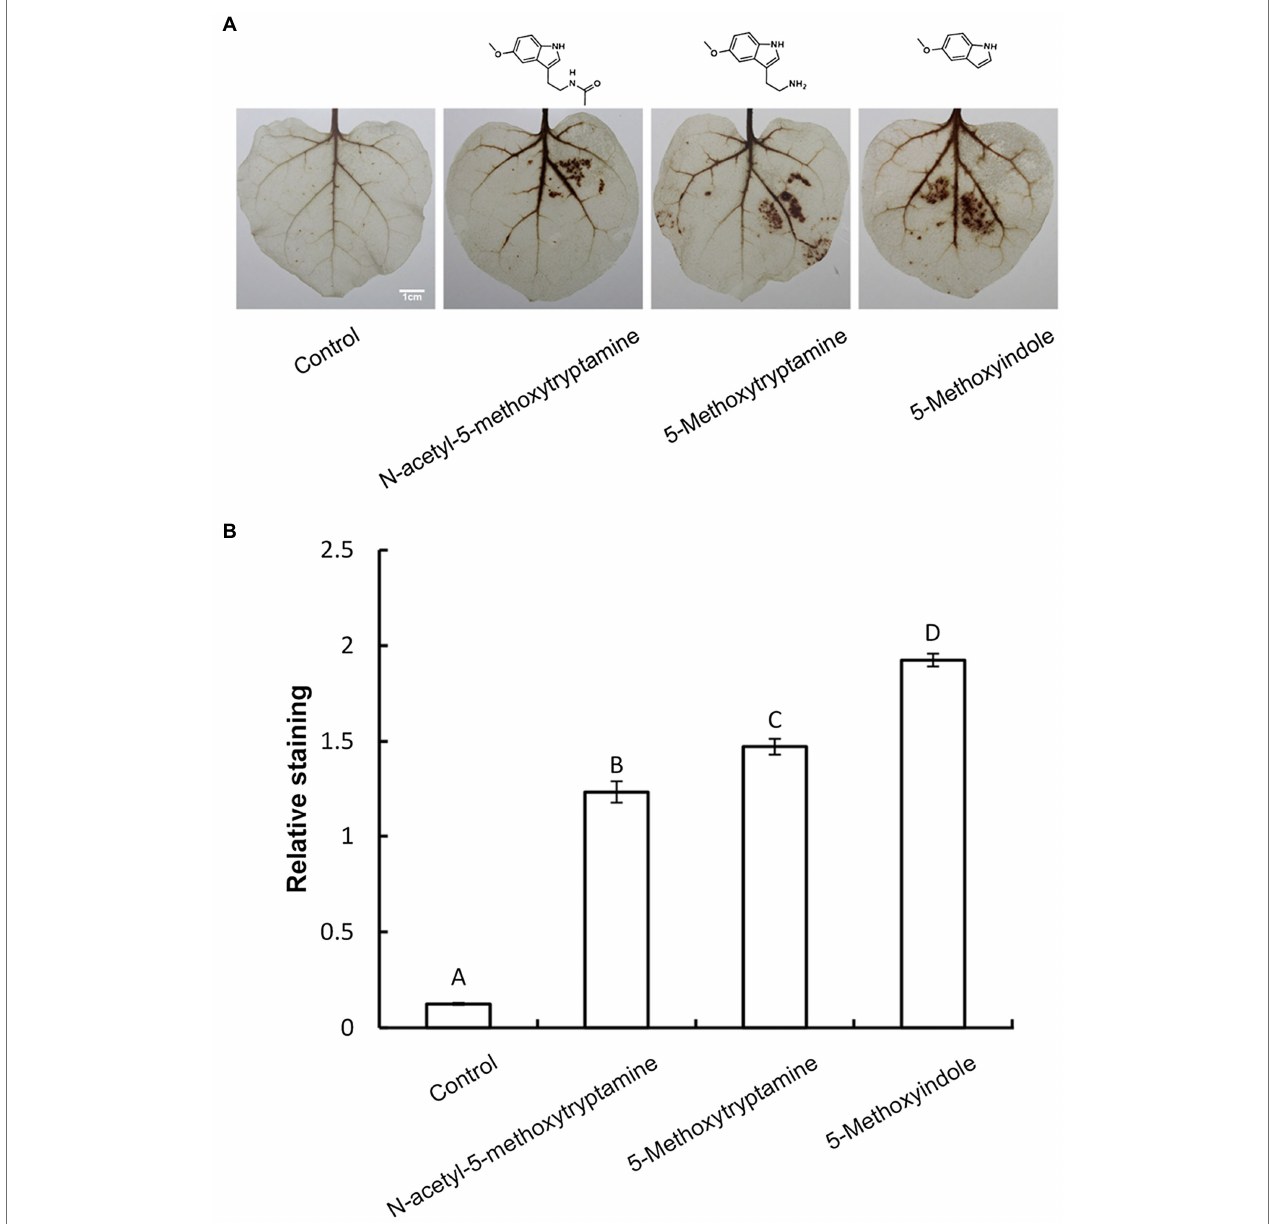
FIGURE 3 | Melatonin and MT-homologs induce the H 2 O 2 accumulation in N. benthamiana leaves. Detection of hydrogen peroxide (H 2 O 2 ) in N. benthamiana leaves treated with various test compounds as determined by diaminobenzidine (DAB) staining. (A) Photographs of representative ethanol-bleached leaves 8 h after treatment with 50 μ M solutions of MT, 5-methoxytryptamine, and 5-methoxyindole. (B) Quantitative scoring of staining in treated leaves. Data are the mean ± standard deviations (SDs; n = 27). Different letters indicate that the means are statistically significantly different at p <